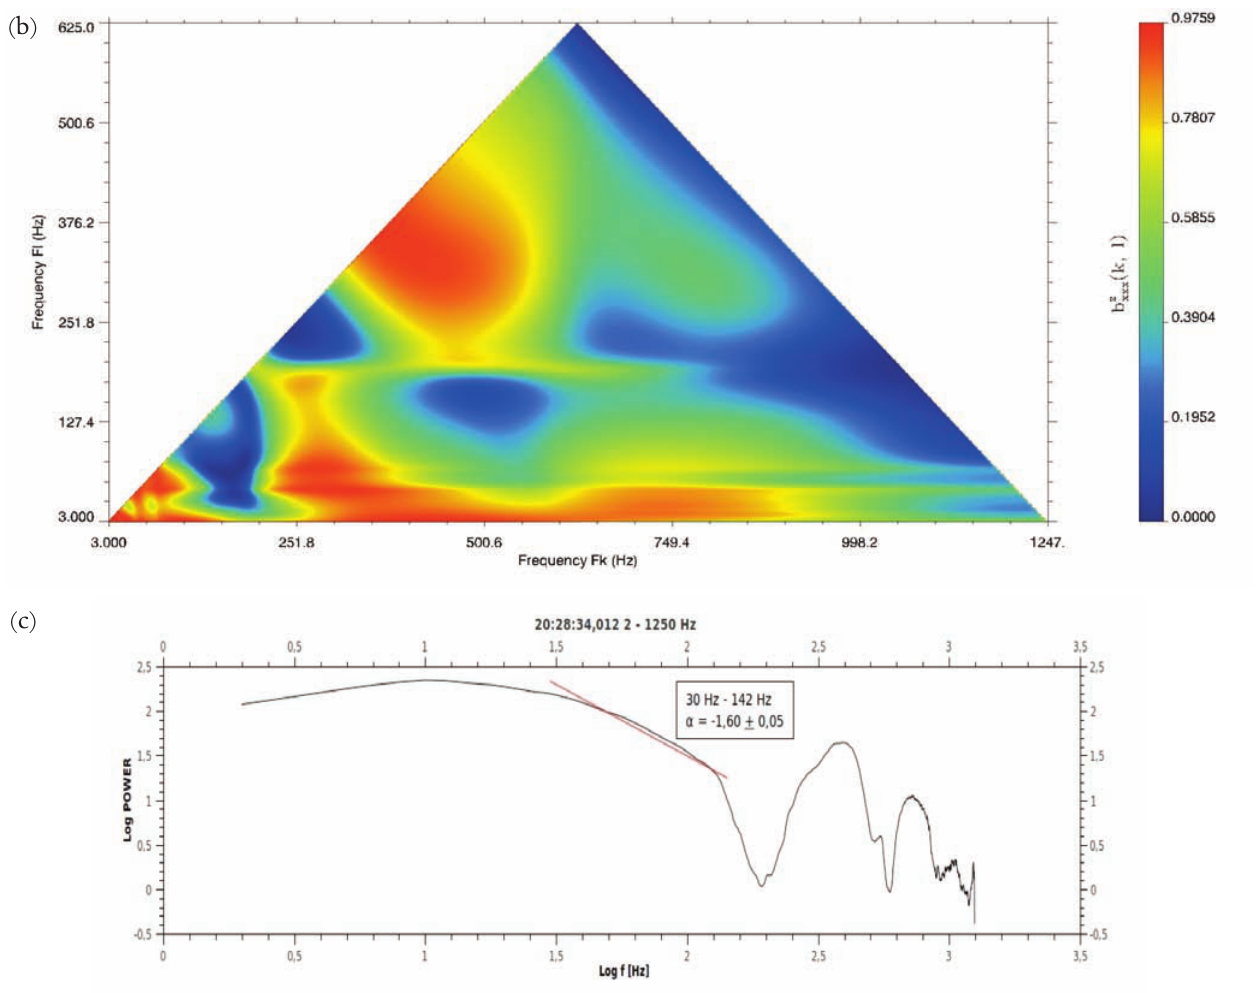
Figure 7b,c. (b) Bispectrum of the Ex signal in the ELF range. For description, see Figure 2b. The pattern of the frequency regions with strong 3-wave interactions is more complicated than for April 1. A clear picture of the turbulent cascade is seen in the lower part of the panel. (c) Single spectrum with slope a c